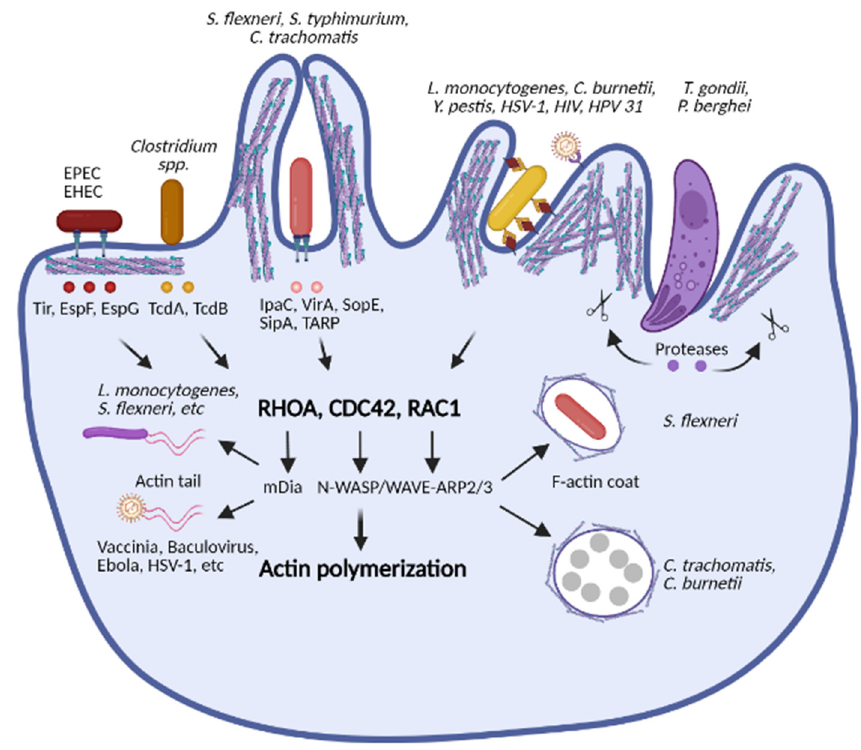
Figure 1. Pathogens cause cytoskeleton disruption. Bacteria and viruses subvert host cytoskeleton dynamics for their entry, intracellular survival and dissemination. They employ various effector molecules, toxins, or viral proteins to induce actin remodeling by manipulating Rho GTPases (RHOA, CDC42, and RAC1), which are the central regulators of the actin polymerization. Parasites such as Toxoplasma gondii and Plasmodium berghei also induce actin rearrangement by binding or cleaving actin-associated factors. Abbreviations: RHOA, Ras homolog family member A; CDC42, cell division control protein 42 homolog; RAC1, Ras-related C3 botulinum toxin substrate 1; mDia, mammalian homolog of Diaphanous; N-WASP, neuronal Wiskott-Aldrich Syndrome protein; WAVE, Wiskott-Aldrich syndrome protein family verprolin-homologous; ARP2/3, actin related protein 2/3; TirA, translocated intimin receptor A; EspF, enteropathogenic E. coli effector protein F; EspG, enteropathogenic E. coli effector protein G; TcdA, Clostridium difficile toxin A; TcdB, C. difficile toxin B; IpaC, invasion plasmid antigen C; VirA, virulence factor A; SopE, salmonella outer protein E; SipA, salmonella invasion protein A; TARP, type III secretion system actin-recruiting effector. Image created with BioRender.com .